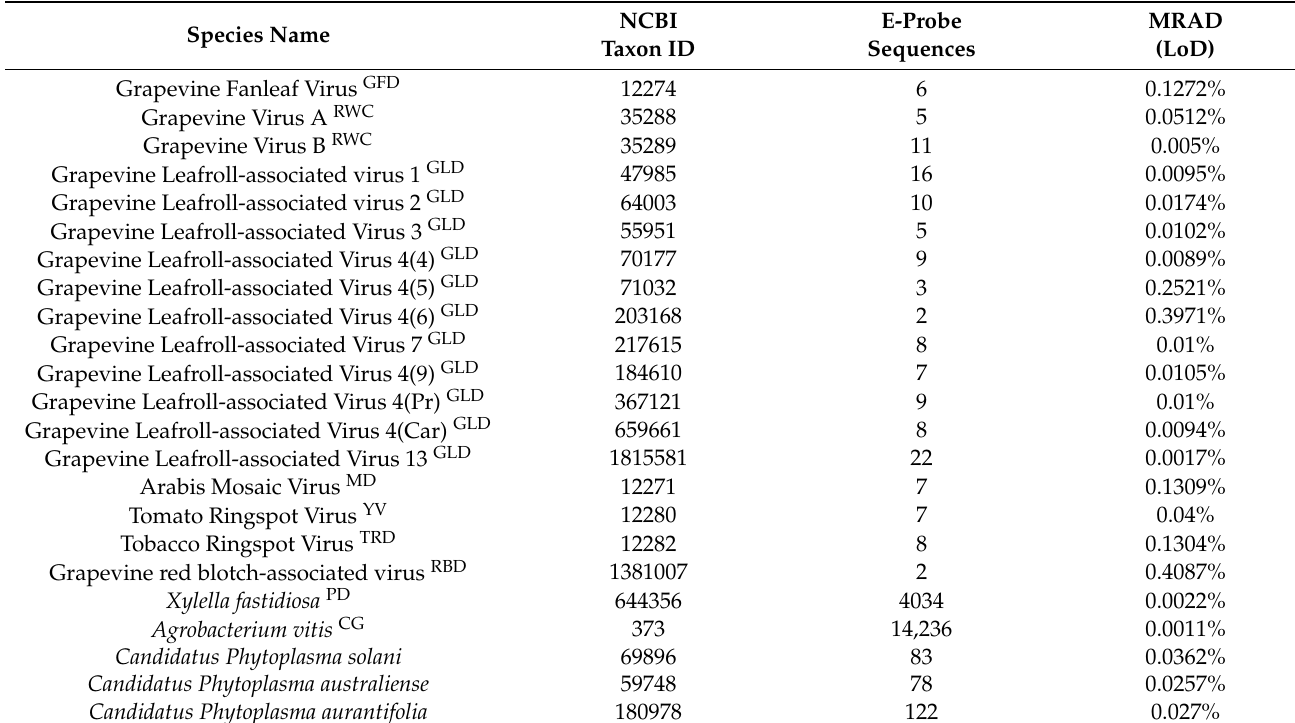
Table 1. Relevant pathogens of grapevine used as a model to demonstrate MiFi ® as an interactive pathogen detection tool. E-probes are sets of unique 60 nt-long sequences. Minimum relative abundance of pathogen reads to detect (MRAD) is calculated by in silico simulations and in vitro experiments over a million total